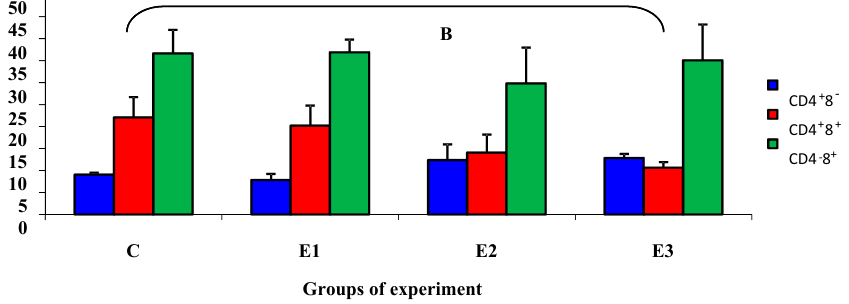
Figure 1. The percentage of individual subpopulation of lymphocytes in the fifth week of the experiment.